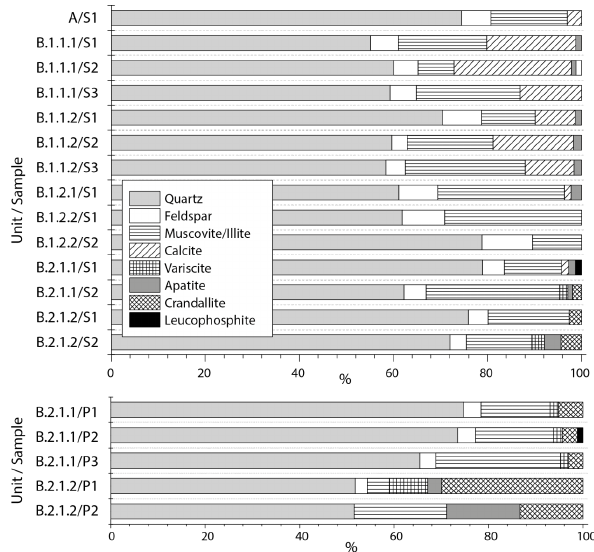
Figure 6. Mineralogical composition in selected samples from Figure 6: Mineralogical composition in selected samples from different sediment units 2 different sediment units (upper) and selected phosphate patches (upper) and selected phosphate patches (lower) of the north profile at square E0 at Arbreda. 3 (lower) of the north profile at square E 0 at